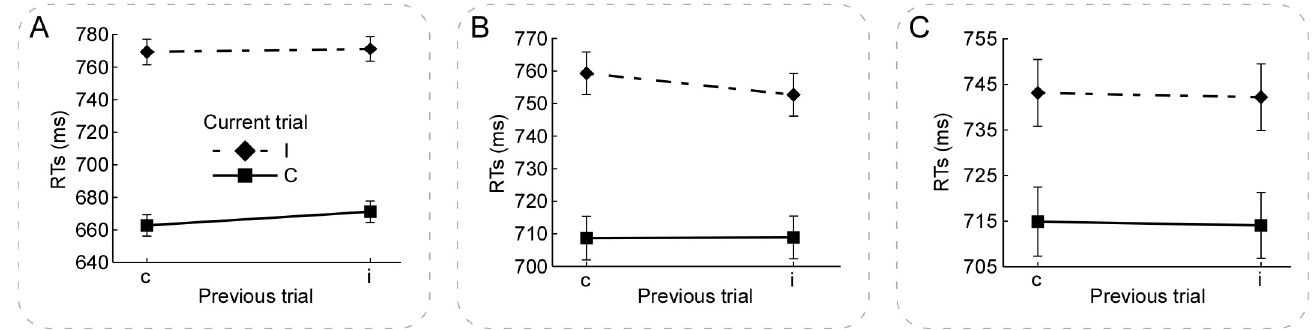
Fig 2. The mean RTs in Experiments 1, 2, & 3. Panels A, B, & C illustrate the mean RTs in the current trial, which was calculated according to the congruency (congruent, incongruent) in the previous and current trials in Experiments 1, 2, & 3, respectively. Panel A shows a significant congruency sequence effect in the current congruent trials in Experiment 1. Panel B shows a significant congruency sequence effect in the current incongruent trials in Experiment 2. Notably, the RTs (iI–iC) was significantly lower than the RTs (cI–cC) in Experiments 1 and 2. Panel C shows a non-significant congruency sequence effect in Experiment 3. For each condition, error bars represent ± SEM across the participants. NB. ‘c’ and ‘C’ are congruent condition, ‘i’ and ‘I’ are incongruent condition, RTs is response times.